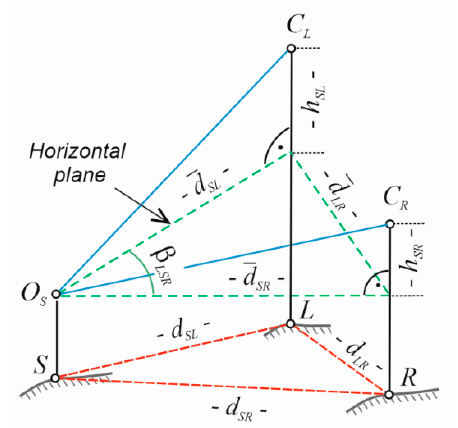
Figure 3. Determination of the horizontal distance d ̅ LR from total station measurement ( S , L , R — points on the ground; C —target points; β —horizontal angle).